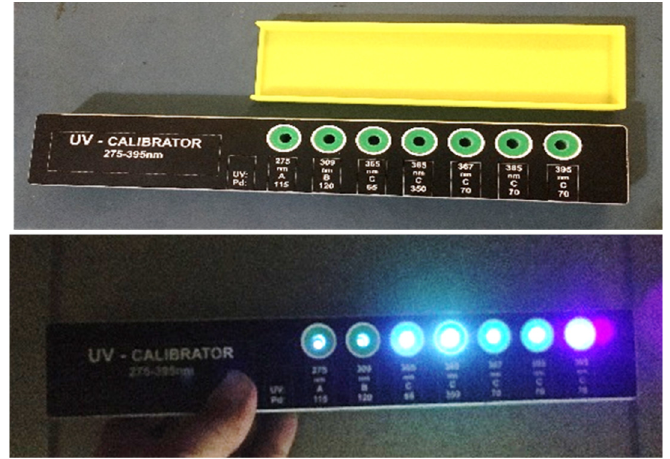
Figure 7. Electronic circuit of calibrator.